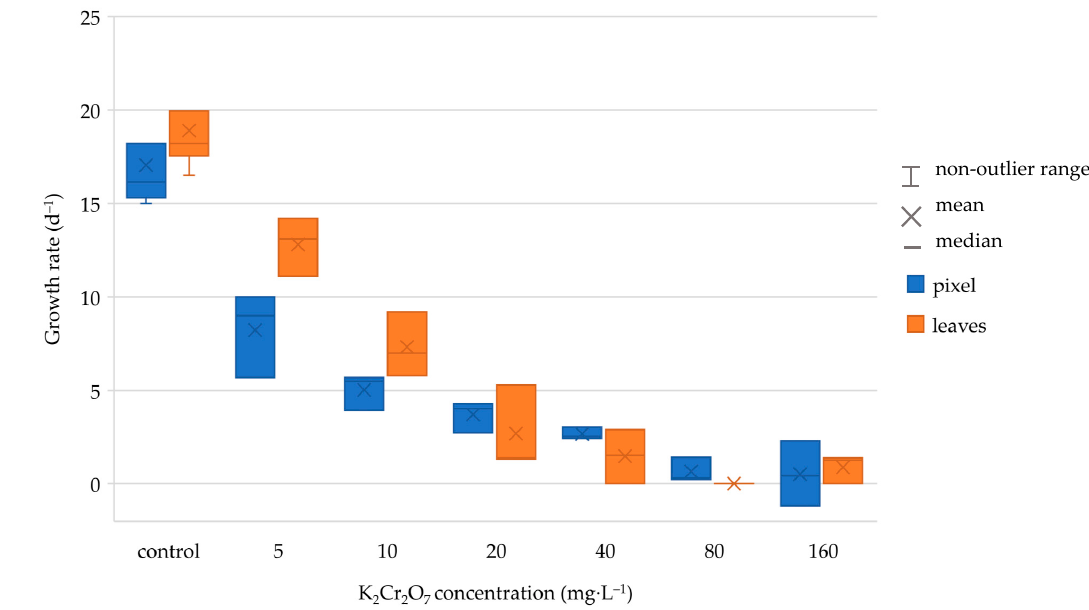
Figure 7. Box and whisker plot of the growth rate for pixels and the number of leaves.